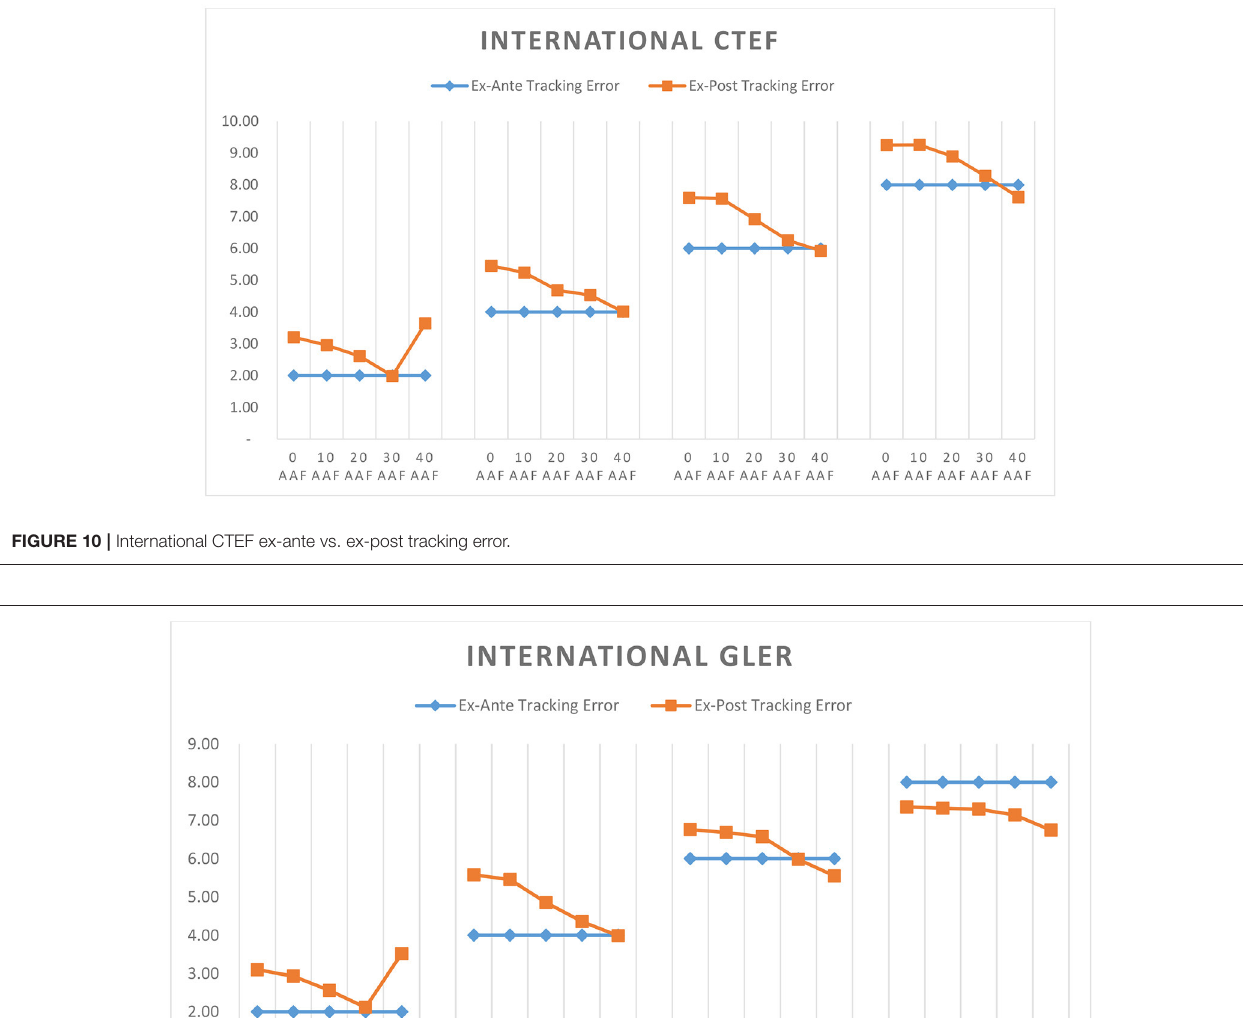
Figure 4 represents 8 years of performance attribution ending September 2016 for all the portfolios at the 6% tracking error level. Each column represents the statistical significance (T-Stat) of the various factor impacts to active return from Axioma’s Fundamental Equity Risk Models. The results in Figure 4 clearly show that momentum is a huge driver of excess return within the CTEF portfolios, with T-Stats exceeding 10 in emerging markets. Value is another statistically significant factor across both CTEF and GLER in all three markets, while Volatility is a large statistically significant detractor of performance consistently across